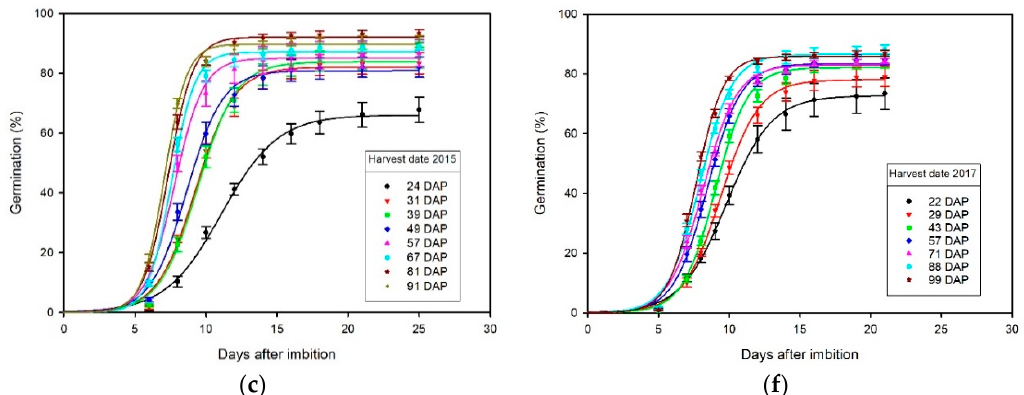
Figure 2. Graphical comparisons of four-parameter logistic (4PL) regression curves of percentage germination over time (days after imbibition), among different harvest dates reported days after pollination (DAP) from germination tests performed: ( a ) 226 DAP with 14 days cold stratification for seed harvested in 2015; ( b ) 266 DAP for seed harvested in 2015; ( c ) 1025 DAP for seed harvested in 2015; ( d ) 225 DAP with 14 days cold stratification for seed harvested in 2017; ( e ) 265 DAP with 0 DPC for seed harvested in 2017; ( f ) 846 DAP with 0 DPC for seed harvested in 2017. Table 1. Four-parameter logistic (4PL) regression parameter estimates for percentage germination in response to the number of days after imbibition for seeds harvested in 2015 across eight different harvest dates numbered by days after pollination (DAP). Standard errors are shown in parentheses.